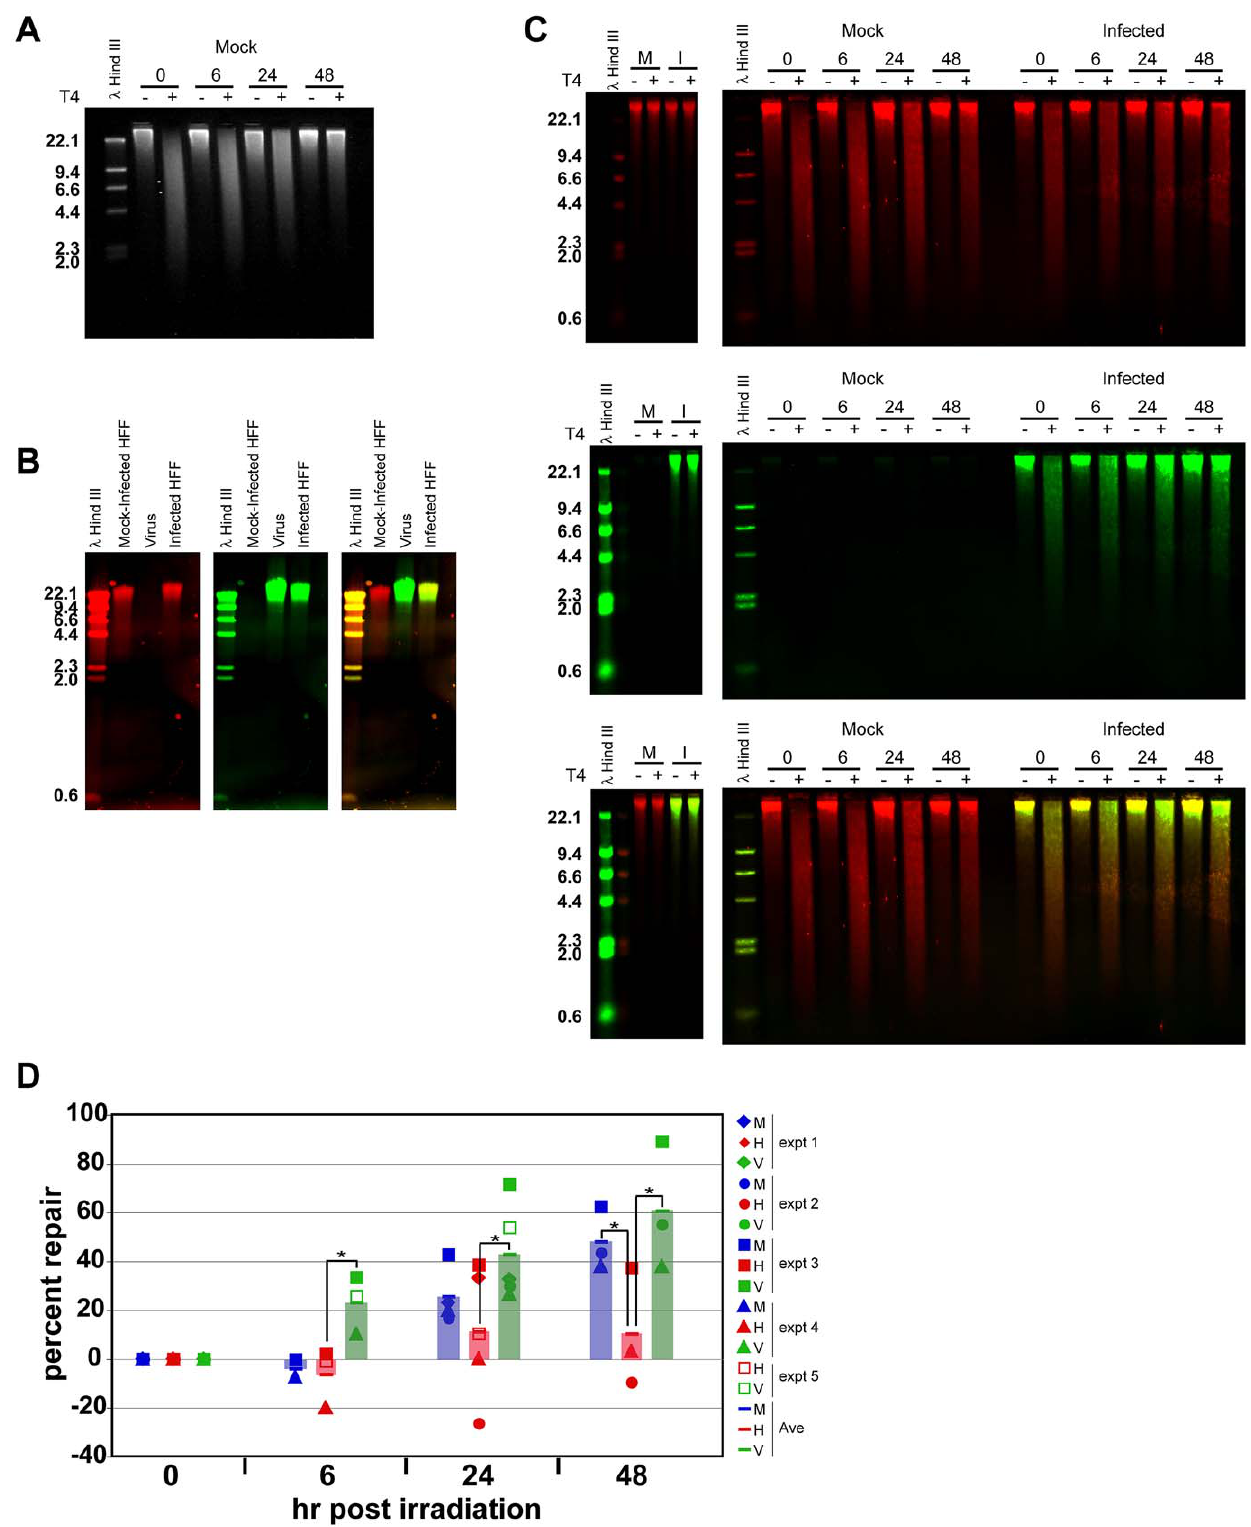
Figure 7. Dual color T4 assays revealed faster and more substantial repair of CPDs in viral DNA of infected cells. A) Mock-infected cells were irradiated with 50 J/m 2 UV at 48 hpi and cells were collected at the indicated times post-irradiation for T4 assay analysis as described in Materials and Methods. Following T4 digestion, fragments were separated on an alkaline agarose gel, which was subsequently stained with SYBR Gold. Sizes of marker fragments are labeled in Kb in all images. B) DNA from mock-infected cells, pelleted virions and virus-infected cells were electrophoresed on a native agarose gel and transferred to nylon membrane. The blot was probed with digoxigenin –dUTP labeled host genomic probes (red - left panel) and biotin-dUTP labeled virus genomic probes (green- middle panel). An overlay image of red and green channels is shown